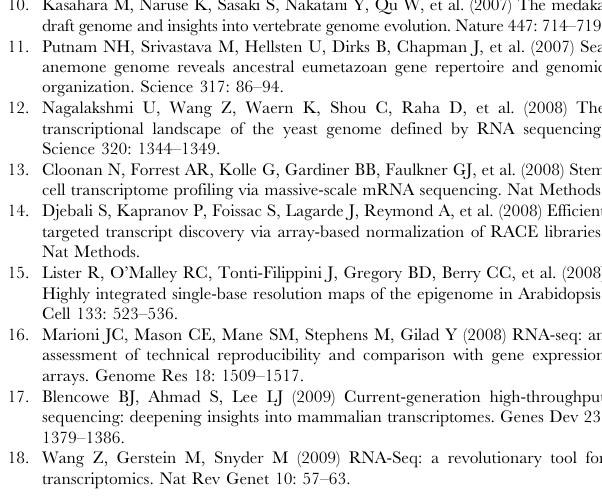
with the Sanger reads from both ends of the cDNA clone. The output had no gap, suggesting successful reconstruction. Figure S4 The x-axis is the nucleotide position from the beginning of the cDNA, while the y-axis represents the number of alignments that covered the position. The two graphs in the left column show the result for the 5 9 -end, while those in the right column are for the 3 9 - end. The two graphs in the top row show the range 0–4 kbp, while those in the bottom row display magnified views of the top two graphs. Red lines show the unique sequence coverage, which is the number of unique alignments that covered a specific nucleotide. Blue lines show the repetitive sequence coverage, which is the number of repetitive alignments that covered a specific nucleotide. Figure S5 The histograms show the clone length distribution of the clones in Library 1 and 1 + 2, colored according to the classification of the assembly results for individual clones. Clones classified as ‘‘not amplified by PCR’’ and ‘‘inconsistent’’ were widely distributed and did not show any clear tendency, suggesting that clone length was related with neither PCR failure nor assembly accuracy. Longer DNA fragments are generally more difficult to amplify. We performed Mann-Whitney U-test and 2- sample Kormogorov-Smirnov test to identify potential bias toward shorter clones. The p-values were 0.38 (Mann-Whitney test) and 0.80 (Kormogorov-Smirnov test), respectively, suggesting that, if any, such bias was too weak to identify. Figure S6 The chart shows the number of CDS-consistent and CDS-inconsistent clones assembled by different assemblers. Among the three assemblers, MuSICA 2 performed better than the others as it could reconstruct more consistent sequences with the least number of inconsistent cases. Output clones that were consistent with the reference CDS structure are colored blue, whereas inconsistent clones are colored red. Figure S7 The diagram shows the accuracy evaluation process for the 780 Toxoplasma gondii full-length cDNA clones in library 3. Of all the 131 PCR-amplified clones with CDS annotation, 97.7% were consistent with the assembled contigs in terms of CDS structure. With regard to unknown sequences, the contigs associated to the clones had an average length of 1,705bp.